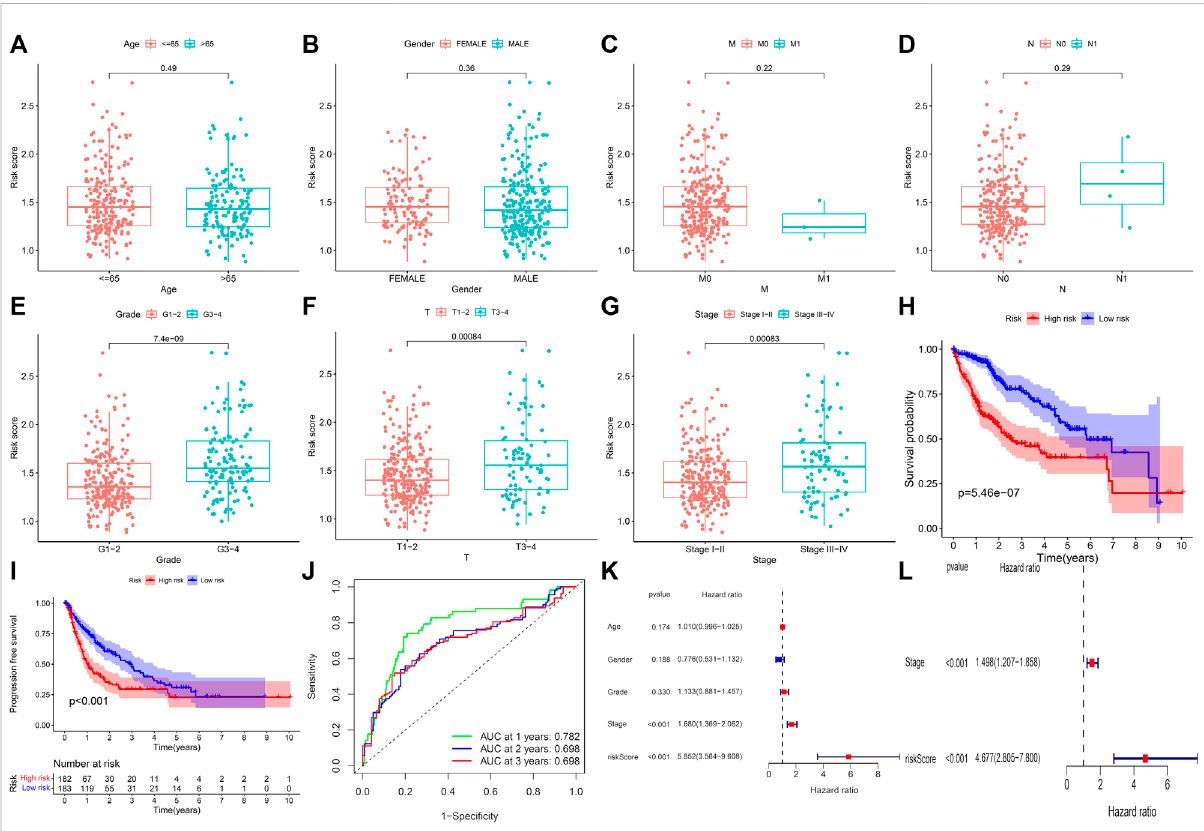
FIGURE 2 Predictive value of CRs scoring model for the survival status of HCC patients in TCGA queue. (A – G) The relationship between risk score and clinicopathological factors, including age (A) , gender (B) , distant in fi ltration (C) , lymphoid metastasis (D) , grade stage (E) , tumor in fi ltration (F) , and pathological stage (G) . (H and I) Comparison of total survival time (OS) and progression-free survival (PFS) in low-risk and high-risk groups. (J) Sensitivity and speci fi city of risk scores measured by ROC curves for predicting 1-, 3-, and 5-year overall survival. (K and L) Forest diagram of univariate and multivariate Cox regression